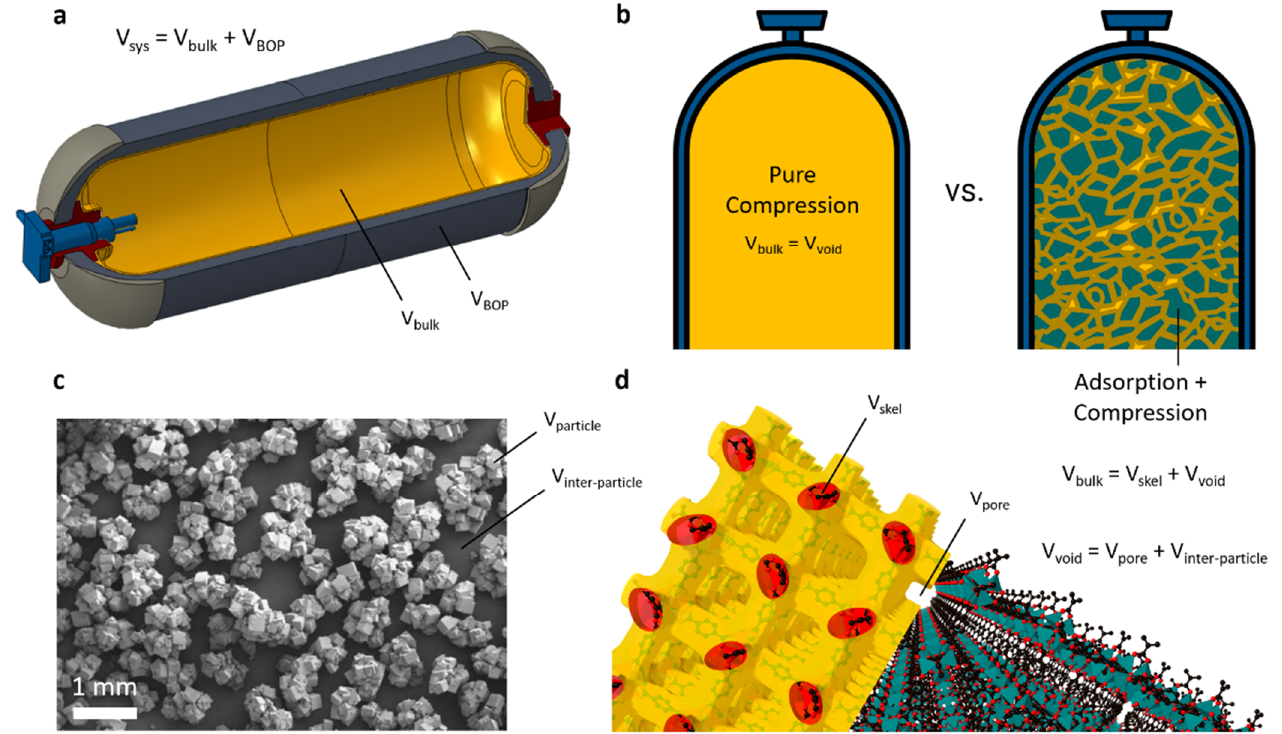
Figure 1. Adsorptive Hydrogen Storage Volumetric Concepts. ( a ) Type-IV composite overwrapped hydrogen compression cylinder [33]. (Adapted from ref. [33]. Copyright 2017 Process Modeling Group, Nuclear Engineering Division, Argonne National Lab (ANL)) ( b ) Schematic depiction of pure hydrogen compression versus adsorptive hydrogen storage, showing both H 2 densification as well as volume exclusion by the solid adsorbent. ( c ) Scanning electron micrograph of high-quality MOF-5 crystals synthesized at laboratory scale (50–150 µ m in size) [34]. (Adapted with permission from ref. [34]. Copyright 2006 Royal Society of Chemistry) ( d ) Atomistic depiction of crystal volume, skeletal volume, and void volume of perfect MOF-5 crystals.